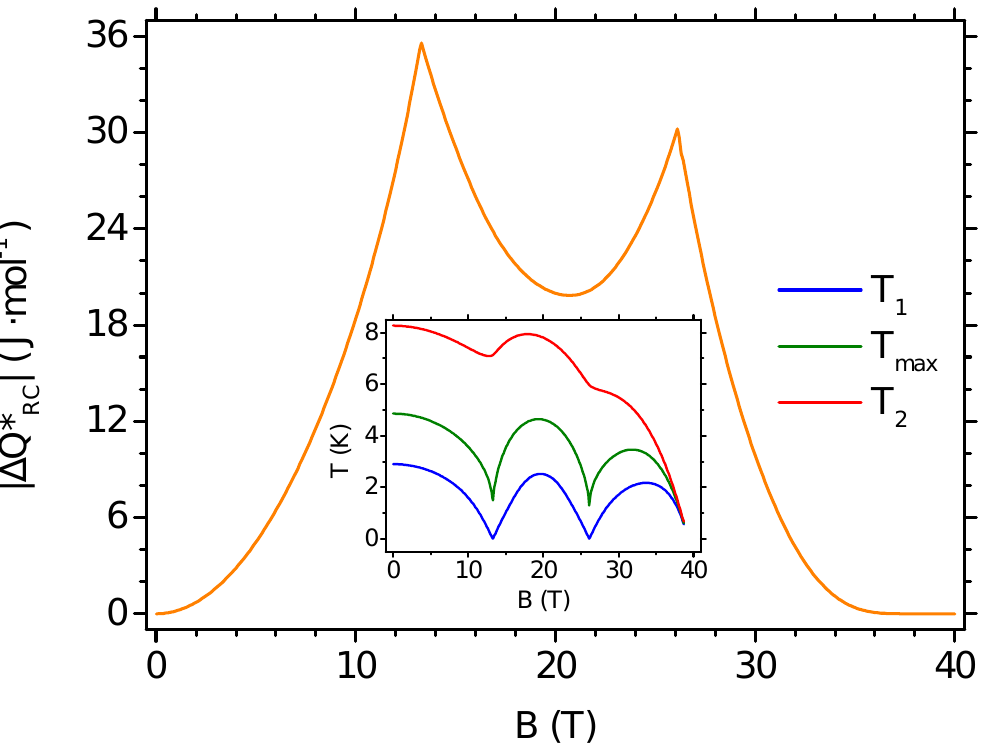
Figure 8. The dependence of the absolute value of refrigerant capacity per mole on the initial value of the external magnetic field in the isothermal process (the final value of the magnetic field is zero), for temperatures between T 1 and T 2 , covering the full width at half maximum of the entropy change peak. The inset shows the dependence of the limiting temperatures T 1 and T 2 as well as the temperature T max at which entropy change reaches the extremum on the initial value of the external magnetic